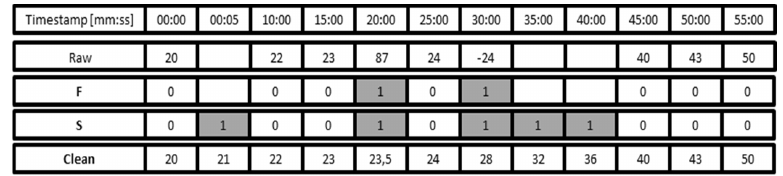
Figure 3. The Clean data row containing raw and synthetic data after the sanitation process.